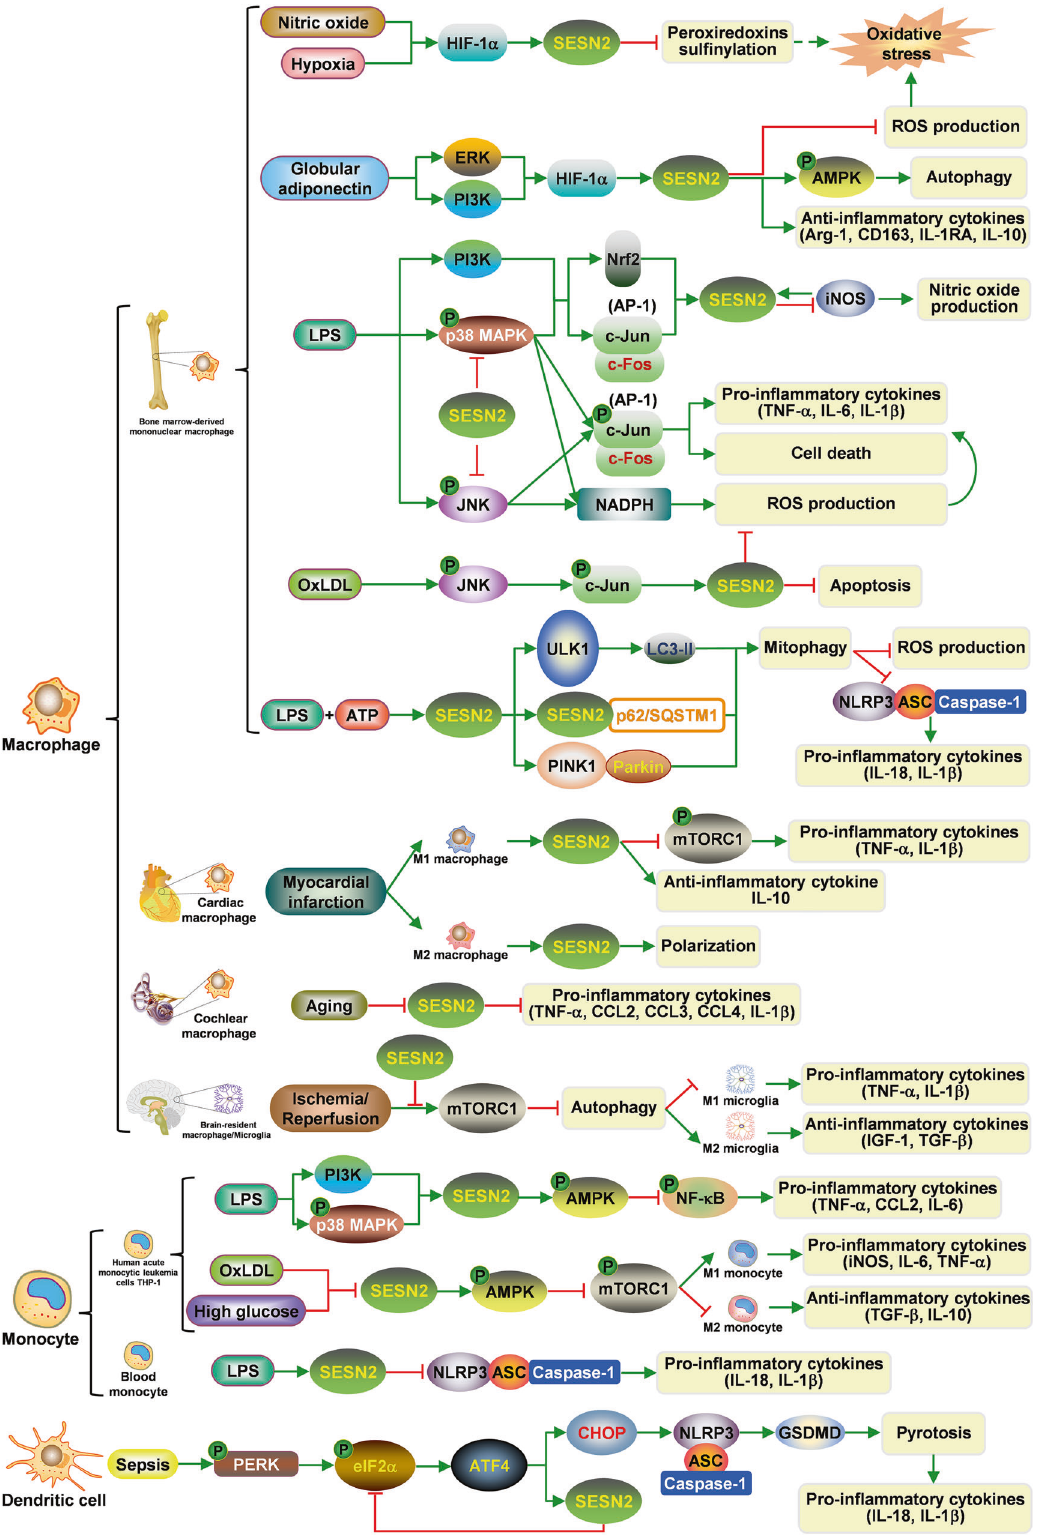
Fig. 4 The roles of SESN2 in in fl ammatory response. SESN2 is expressed in immune cells including macrophages, monocytes, and dendritic cells, and architects cellular responses to in fl ammatory insults. SESN2 when induced by stimuli can exert robust anti-in fl ammatory function, which is associated with scavenging ROS, promoting autophagy, reducing in fl ammasome, and diminishing cell death.